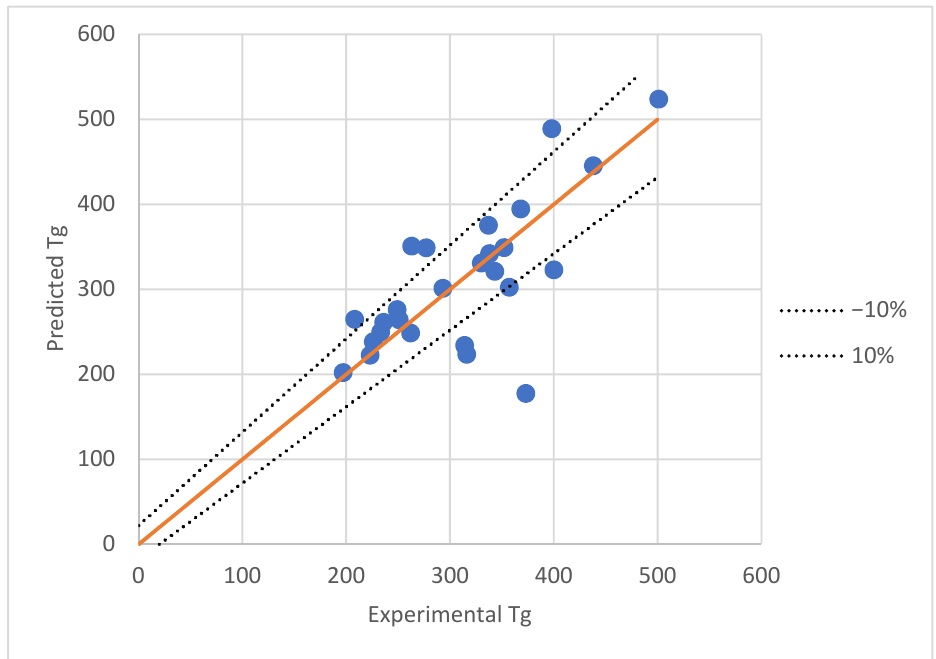
Figure 3. Comparison between experimental and ANN predictions for the testing data in the case of the best model obtained for all the data.